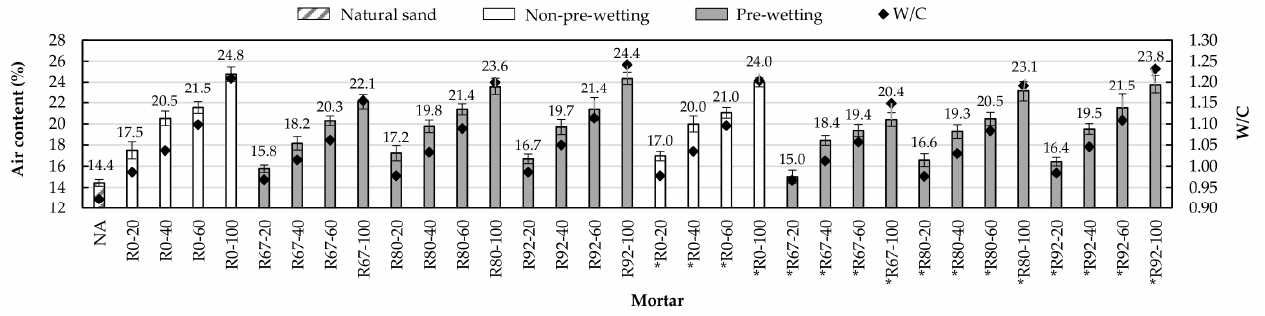
Figure 6. Values of air content and W/C ratio.